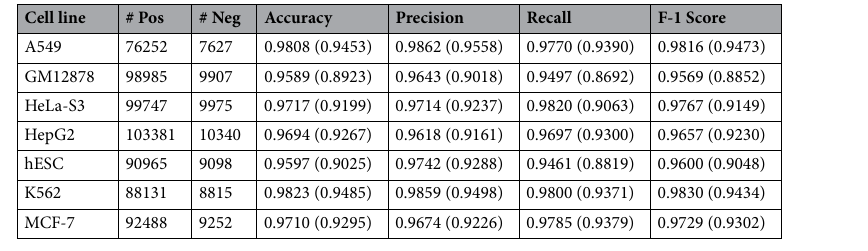
Table 3. The performance of D-miRT models on unseen cell line data The numbers in parenthesis are those without threshold values.